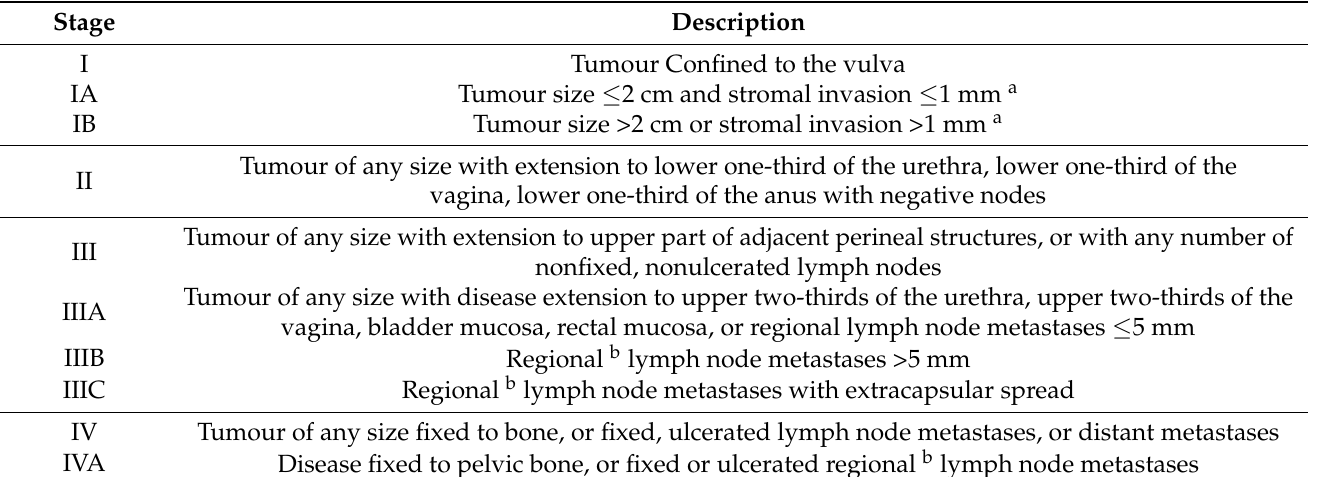
Table 1. 2021 FIGO Staging of Vulvar Carcinoma